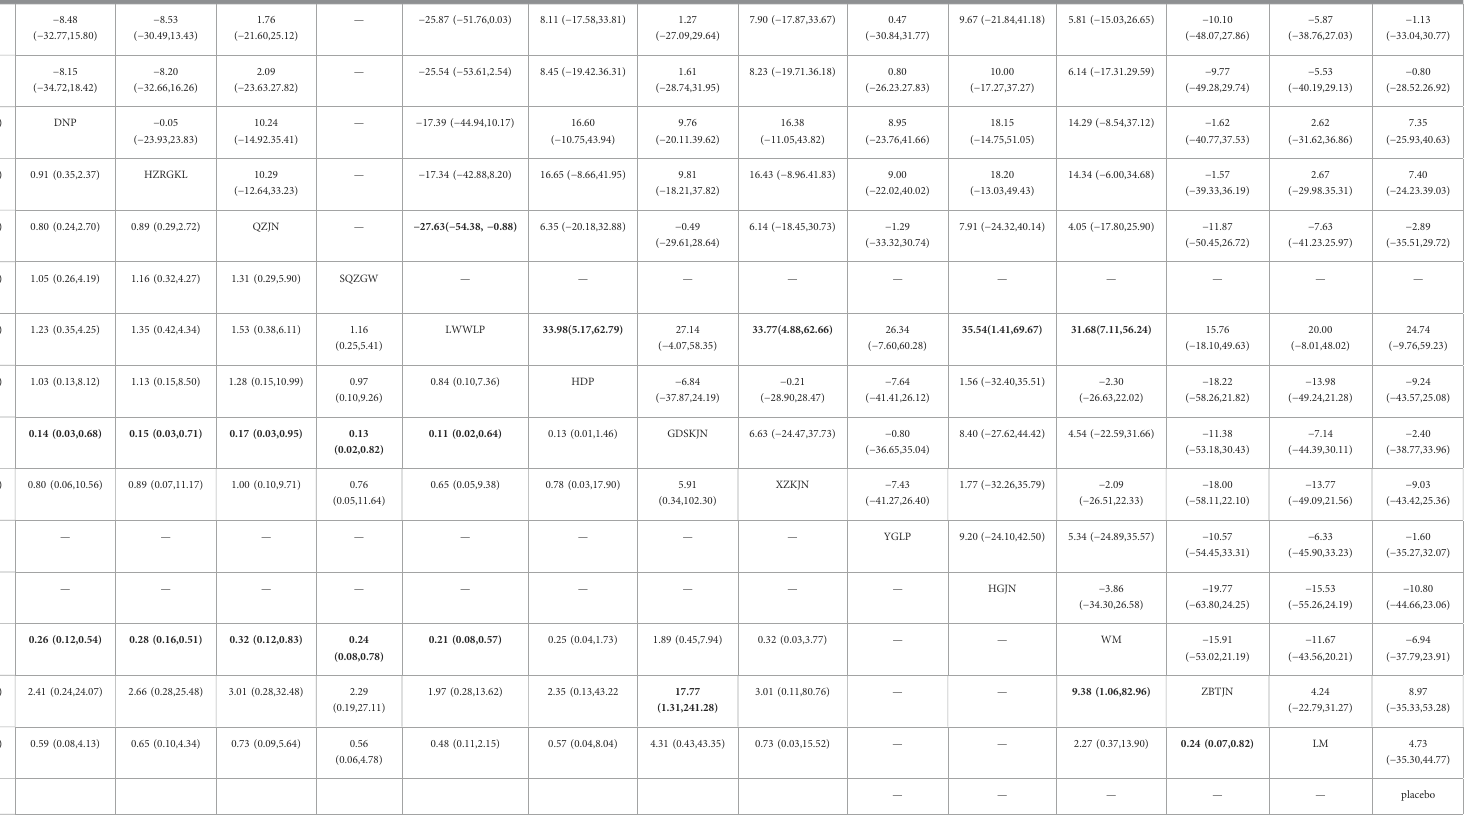
TABLE 2 The league table of Clinical ef fi ciency rate and ALT. Comparisons for clinical ef fi ciency rate (bottom left) and ALT (upper right) of CPMs QGJN − 0.33 ( − 25.17,24.50)